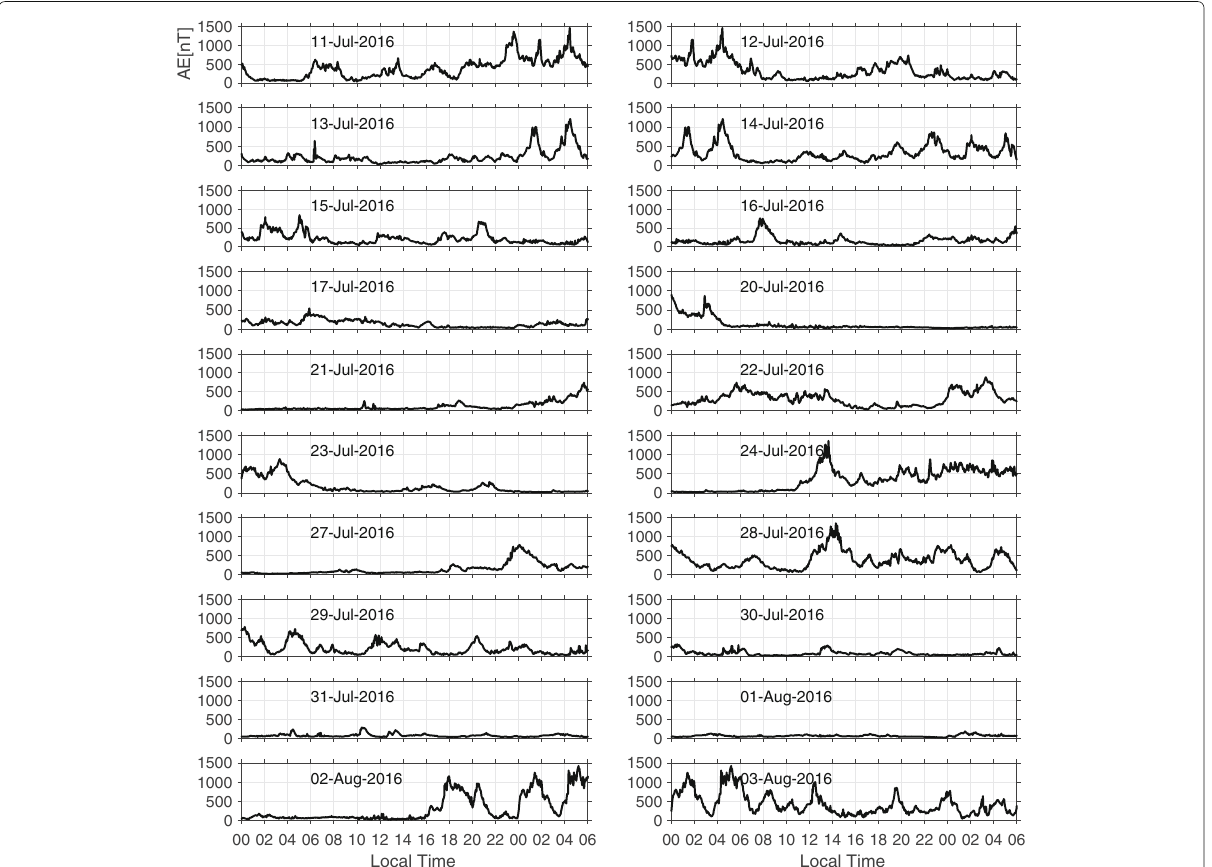
Fig. 3 The auroral electrojet (AE) index for each observation day of the campaign period. The starting date is indicated in each panel. Note the difference in the time axes with respect to Fig. 1